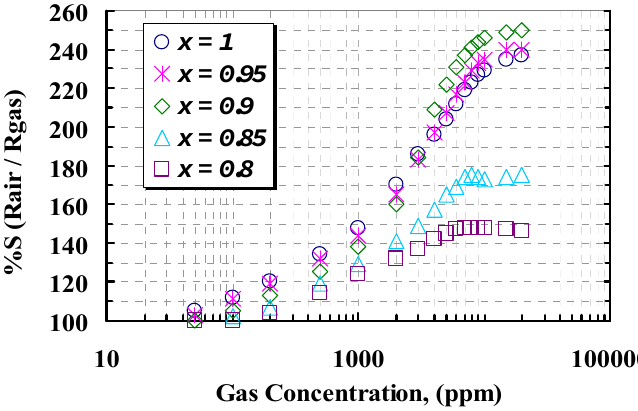
Figure 11. Sensitivity of samples to different concentration of CH temperature of 405 °C ( x = 1), 395 °C ( x = 0.95), 380 °C ( x = 0.90), 440 °C ( x = 0.85), and 450 °C ( x = 0.80).